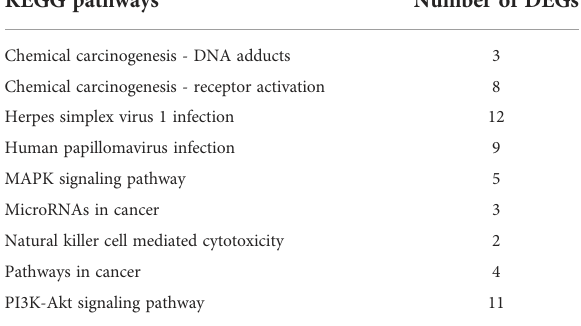
TABLE 3 Summary of signi fi cantly enriched immune-related KEGG pathways after co-exposure.